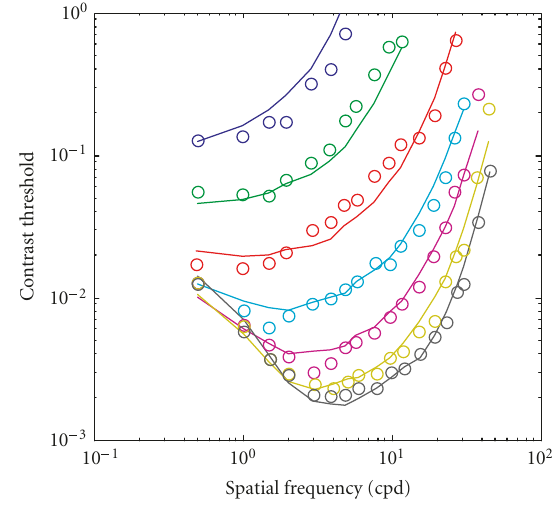
Figure 1: Contrast threshold versus spatial frequency, with mean retinal illuminance ranging from 0 . 0009 (top) to 900 (bottom) trolands in log steps. The data points are from Van Nes and Bouman [16] and the smooth curves are the fits with current model (see